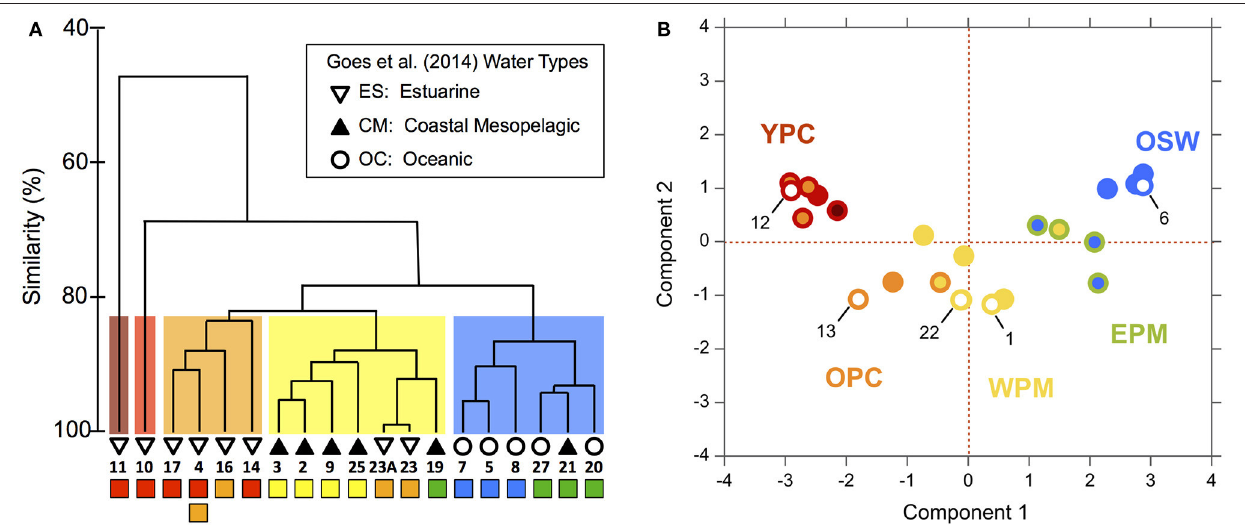
FIGURE 7 | (A) Dendrogram of ALF data from Goes et al. (2014) where clusters have been grouped at ∼ 83% similarity according to the colored boxes behind the clusters and are referred to as “cluster groupings” in the main text. The colored squares below the station numbers correspond to our habitat-type categorizations. See Figure 4 for additional information. (B) PCA of habitat-defining variables from Figure 2 comparing the ALF cluster groupings to the habitat types, where the marker border color has been kept the same so as to match habitat types, whereas the marker fill color was changed to match that of the ALF cluster groupings (A) . Markers filled with white represent CTD casts from stations that had no corresponding ALF dataset. Only one CTD cast per station is shown (see section Materials and Methods); note that the marker of Station 25 is nearly fully eclipsed by that of Station